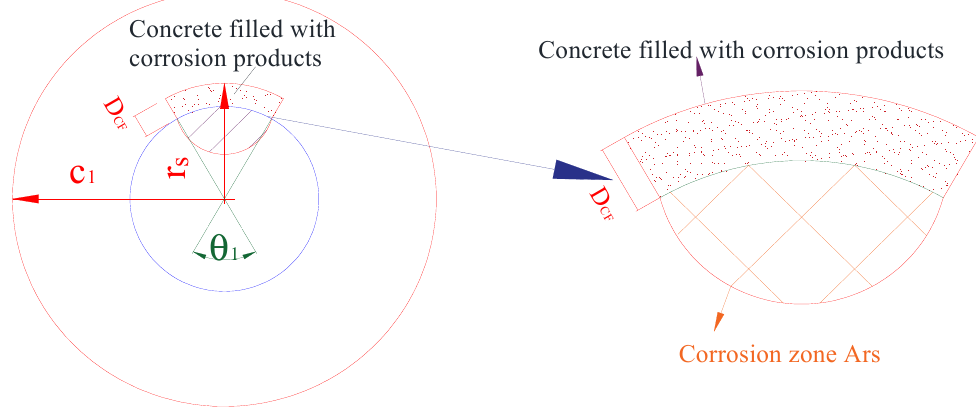
Figure 4. No stress thick-walled cylinder with non-uniform corrosion.